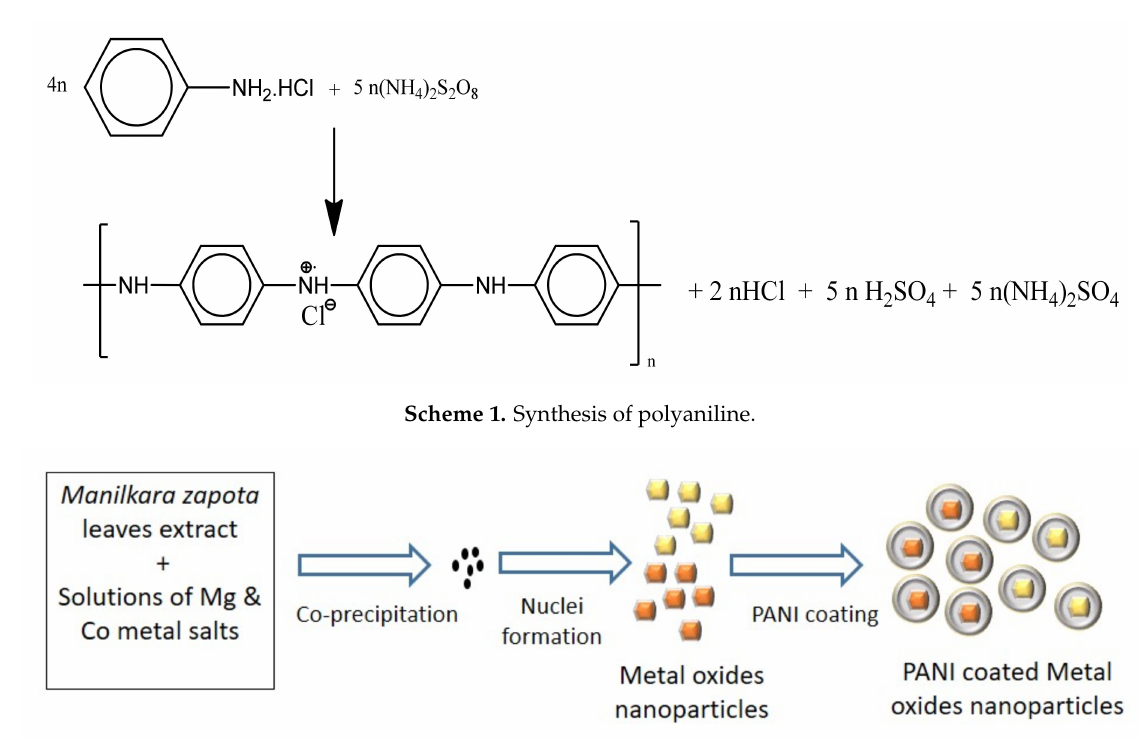
Figure 2. Schematic representation of synthesis of studied nanoparticles.